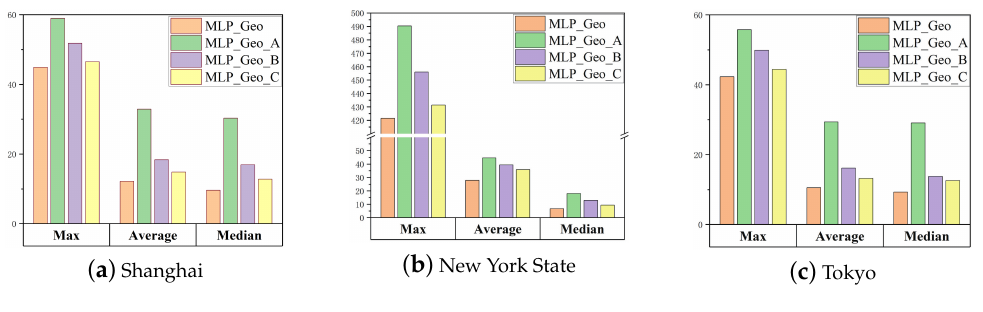
Figure 6. Ablation study in the three experimental